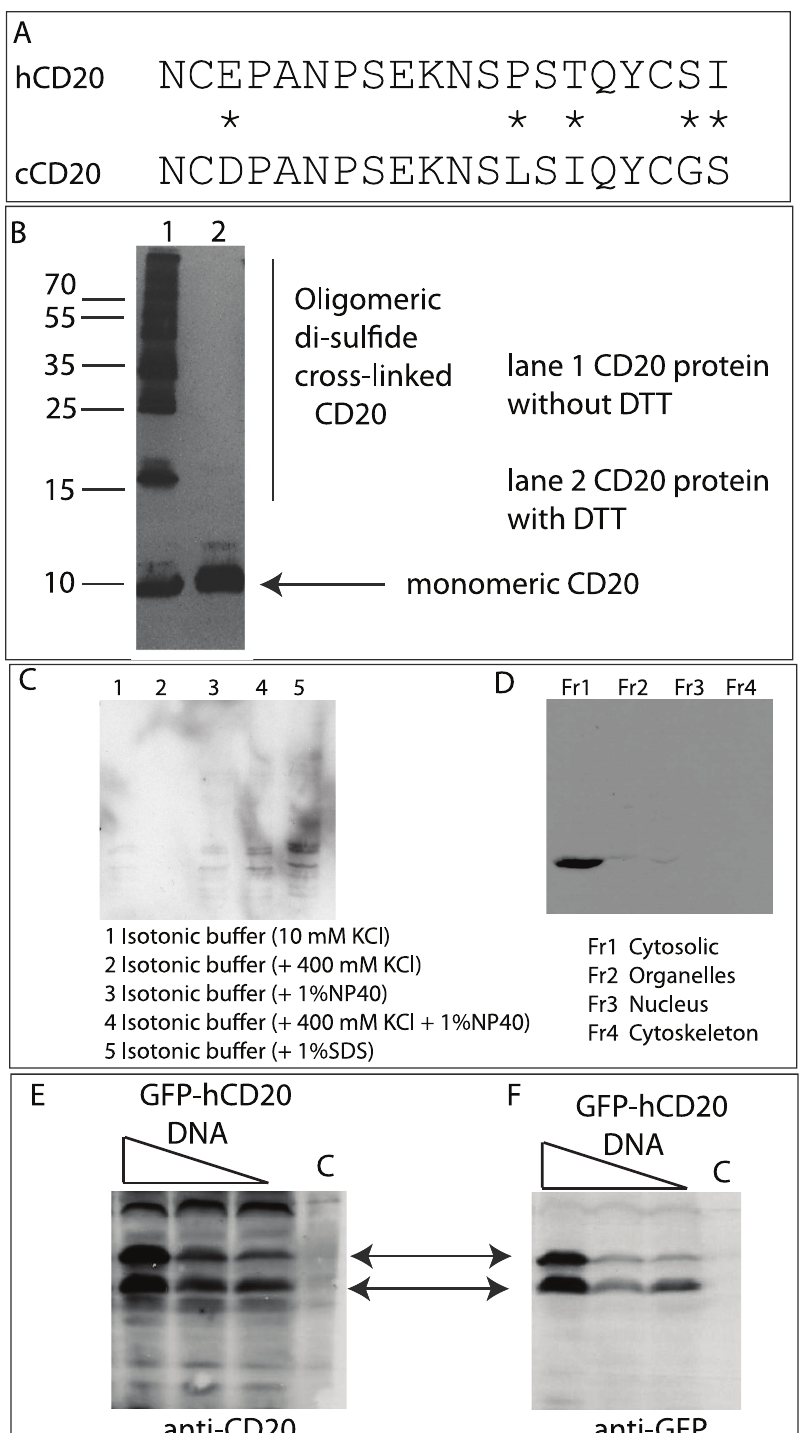
Fig 1. Isolation of a mouse CD20-specific monoclonal antibody that can recognize human and canine CD20 protein. (A) . Amino acid sequence of human and canine CD20 surrounding the Rituximab epitope . The asterisks highlight divergence between human (hCD20) and canine (cCD20) proteins. ( B) . Immunoblotting of recombinant canine CD20 protein . Bacterially expressed his-tagged canine CD20 protein (amino acids 140 – 190) was purified by nickel chromatography and after electrophoresis without and